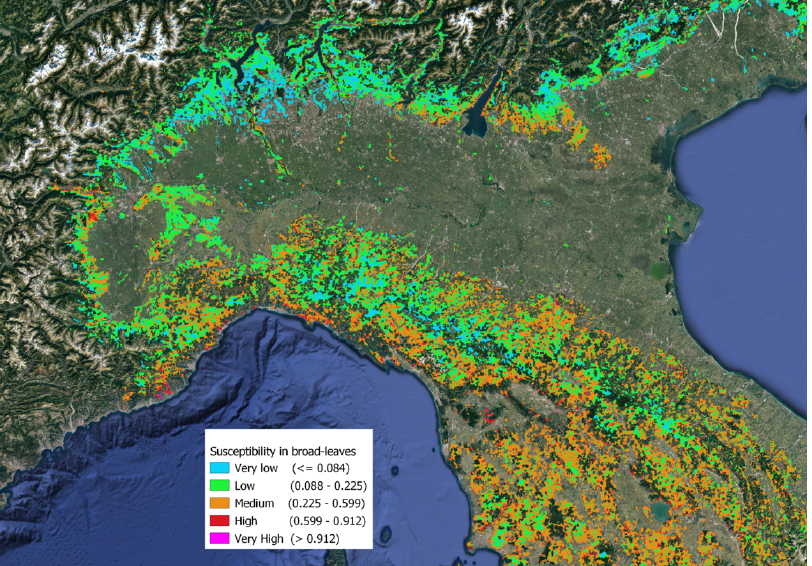
Figure 20. Details of the summer wildfire susceptibility over the pixels characterized by CLC18 class 311, corresponding to broadleaves, are represented, with the color palette of the national map of Figure 15. The figure refers to the broadleaves distribution over northwestern Italy. Even if the selected pixels share the same CLC land cover, there is a trend of higher wildfire susceptibility in close proximity to the coastline, and generally lower susceptibility in mountain areas, such as in the Alps and Apennines